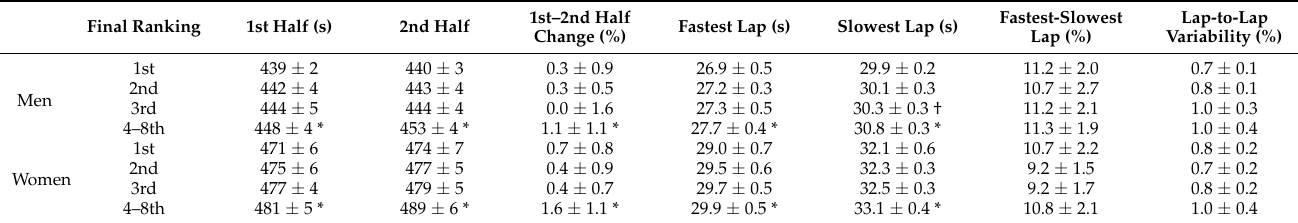
Figure 1. ( A ) Lap times for men swimmers for the 1500 m freestyle races of the World Championships between 2003 and 2019 according to their final position in the race; ( B ) Race velocity in each lap with respect to the average race velocity. (*) Statistically significant difference between 1st and 4–8th positions at p < 0.05. (†) Statistically significant difference between 1st and 3rd positions at p < 0.05. Error bars have been removed for clarity. Table 1. Time for the first and second half of the race and the fastest and slowest laps in the 1500 m freestyle races of the World Championships between 2003 and 2019 according to their final position in the race; (*) Statistically significant difference between 1st and 4–8th positions at p < 0.05. (†) Statistically significant difference between 1st and 3rd positions at p <